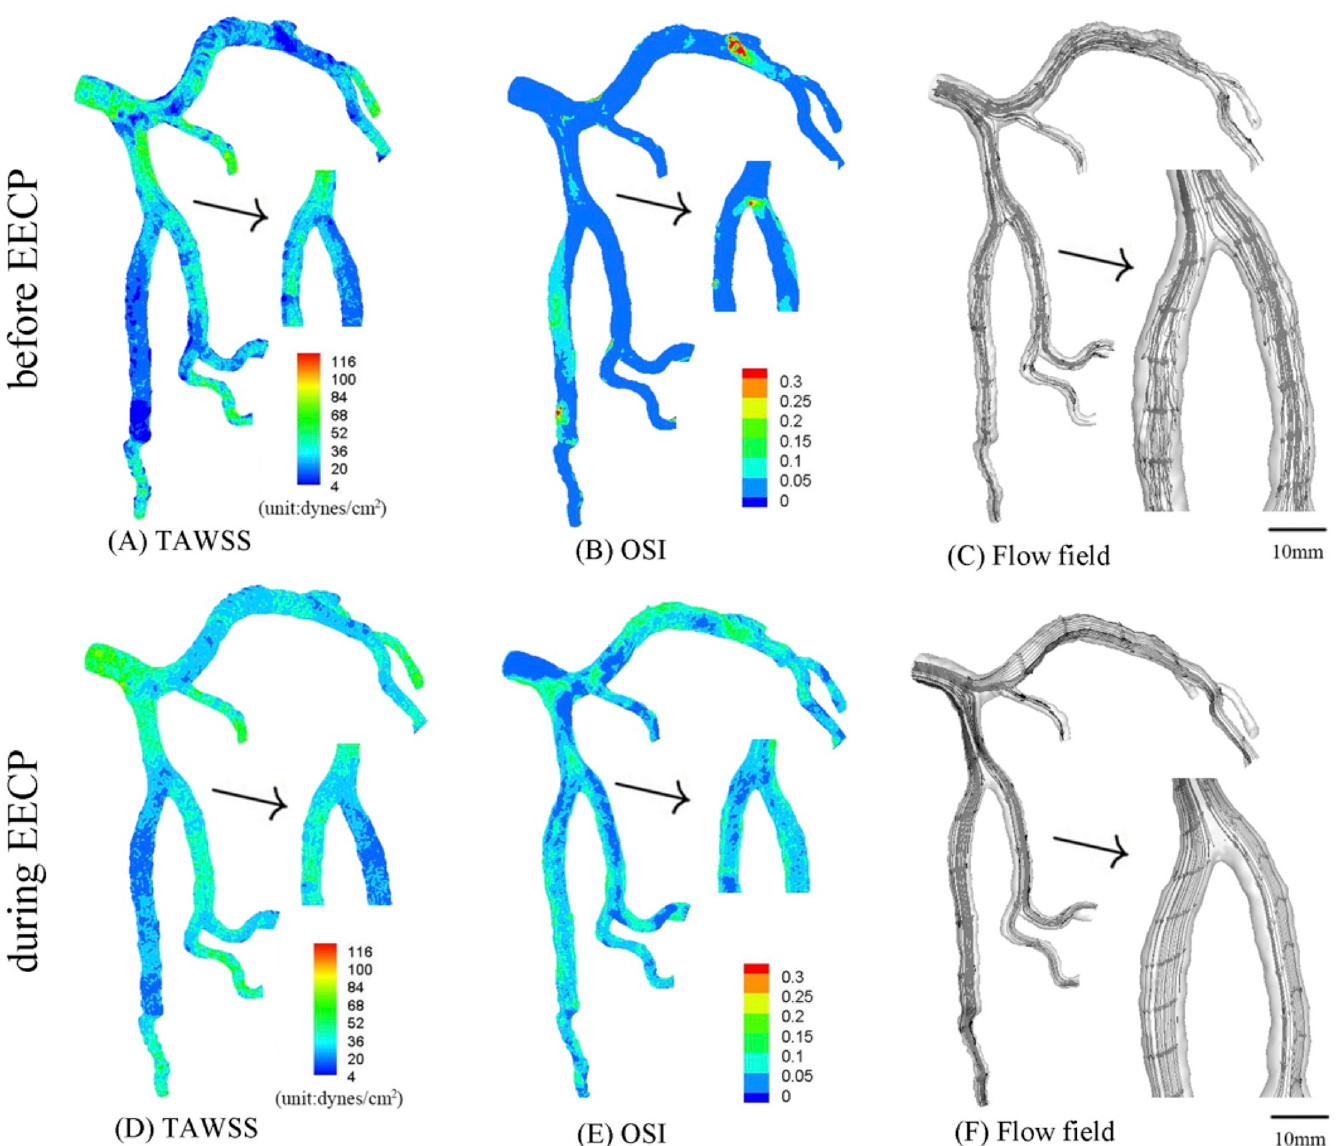
Fig 4. In correspondence with Fig 1A, TAWSS (A), OSI (B) and flow field (C) in the epicardial tree that has an idealized 50% area stenosis at the parent vessel (stenotic length of 7.3 mm) in the first bifurcation of LAD arterial tree before EECP; TAWSS (D), OSI (E) and flow field (F) in the same tree during EECP. The small figures for TAWSS and OSI show the posterior view. The small figures for flow field show the zoomed view. https://doi.org/10.1371/journal.pone.0230144.g004 equals to Surface area OSI � 0 : 15 � 100% ð 2 Þ Surface area near a bifurcation , where surface area of OSI � 0.15 is high-risk area) were computed at coronary bifurcations using the method in Ref. [31]. The average peak velocity along the main trunk of epicardial left anterior descending artery (LAD) was computed. The curve fitting in Fig 6 was presented using Matlab software (R2014a, MathWorks, USA).